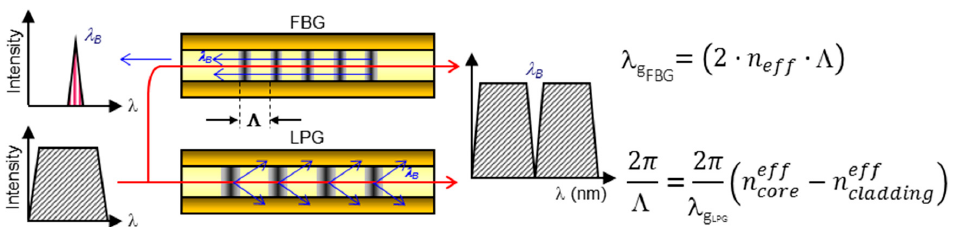
Figure 7. Working mechanism from a FBG and a LPG: inset, the formula for each case that determines the Bragg wavelength.